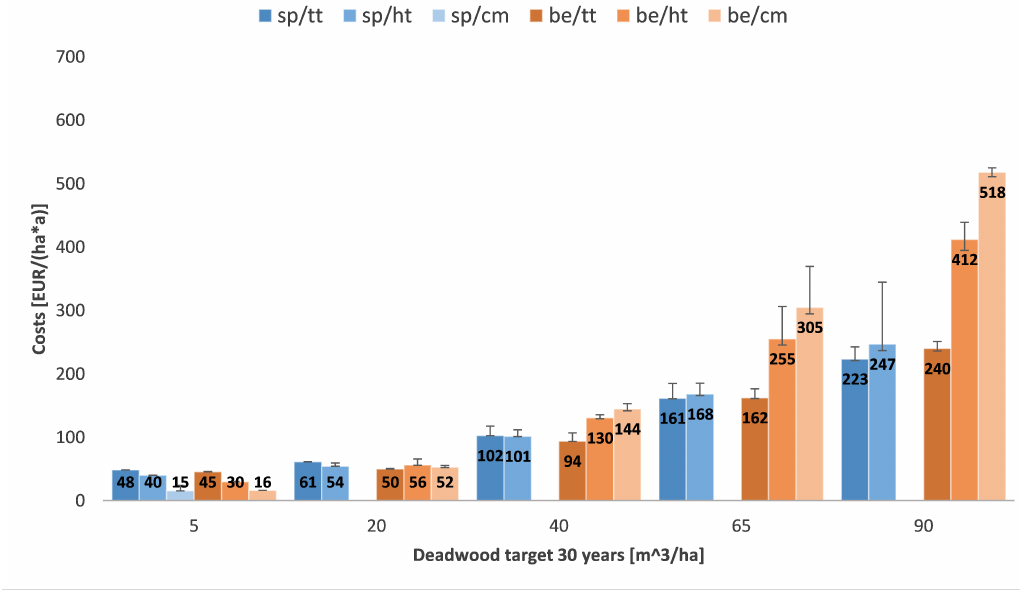
Figure 3. Forest enterprise “Eichelberg”: Costs in [ e ha − 1 a − 1 ] for target deadwood amounts in [m 3 ha − 1 ], to be maintained within 30 years. Blue columns show spruce ( sp ) and orange beech strategies ( be ). tt : Total tree, ht : Heavy timber, cm : Crown